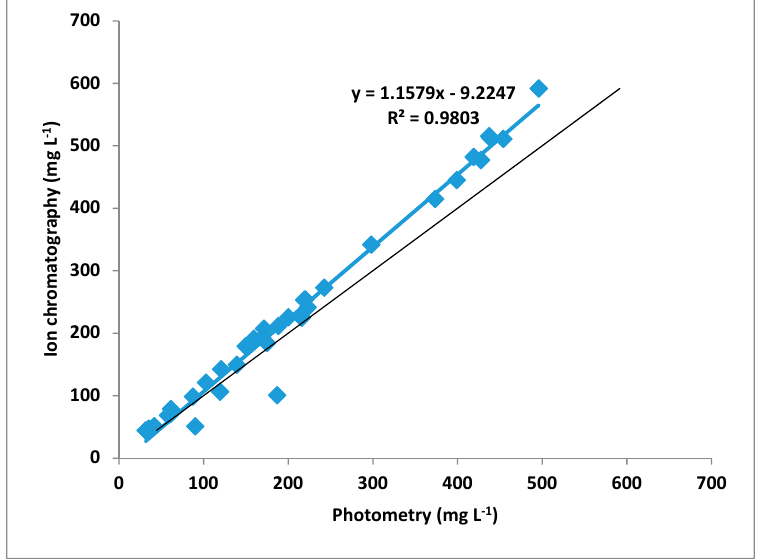
Figure 4. Correlation of nitrite concentration measured with photometry and with ion chromatography.